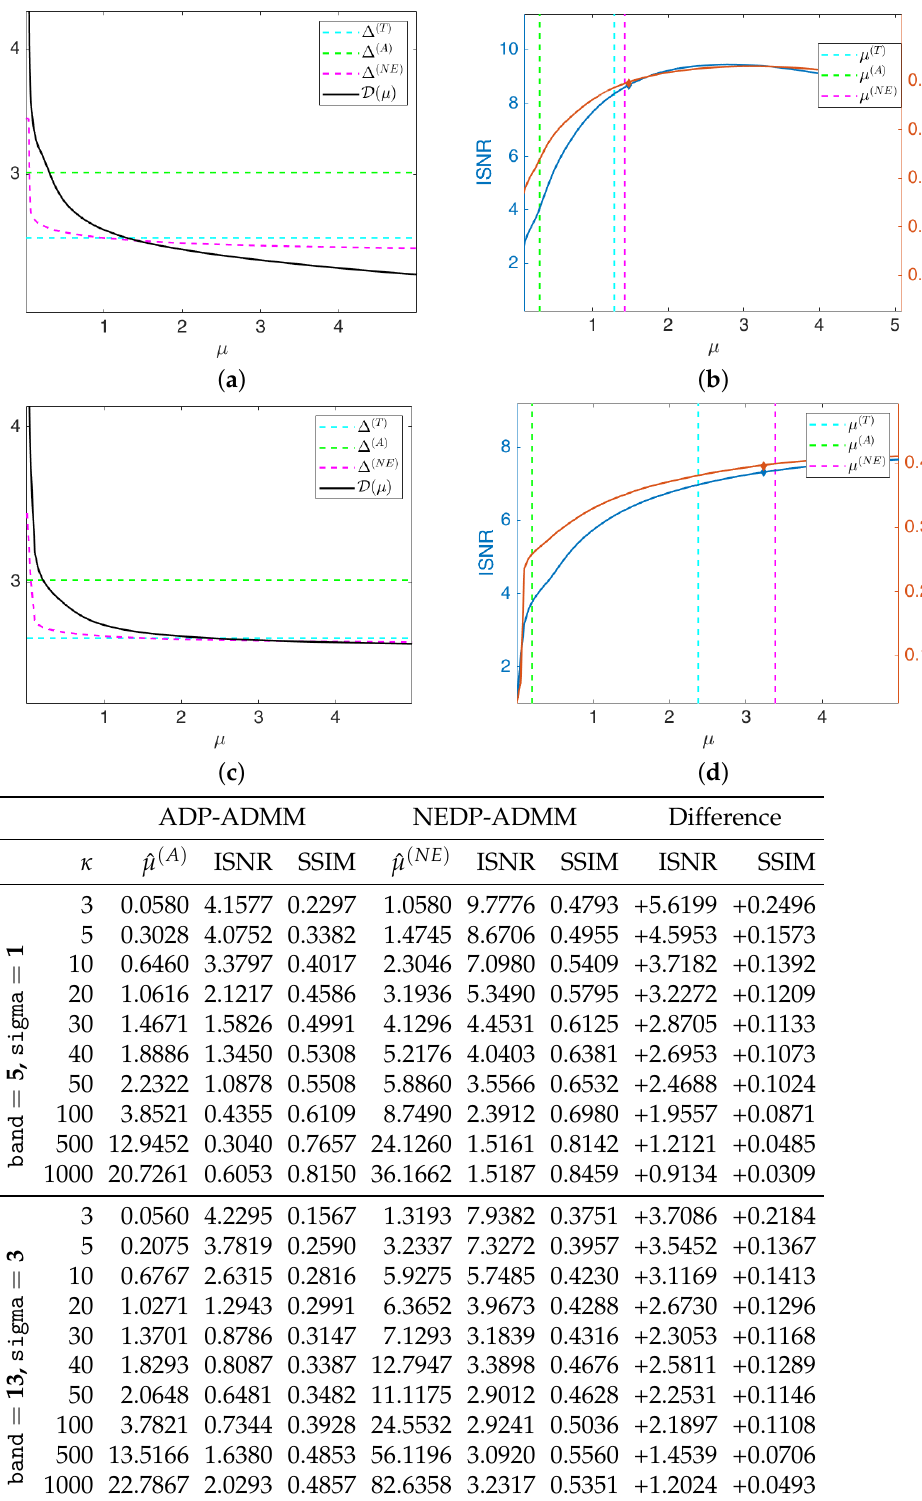
Figure 9. Test image brain . Top : discrepancy curve divided by 10 4 ( a , c ) and ISNR/SSIM values ( b , d ) achieved for different µ -values with κ = 5 and Gaussian blur with parameters band = 5, sigma = 1 ( first row) and band = 13, sigma = 3 ( second row). Bottom : output µ -values and ISNR/SSIM values obtained by the ADP-ADMM and the NEDP-ADMM for the two blur levels considered and different photon counts κ